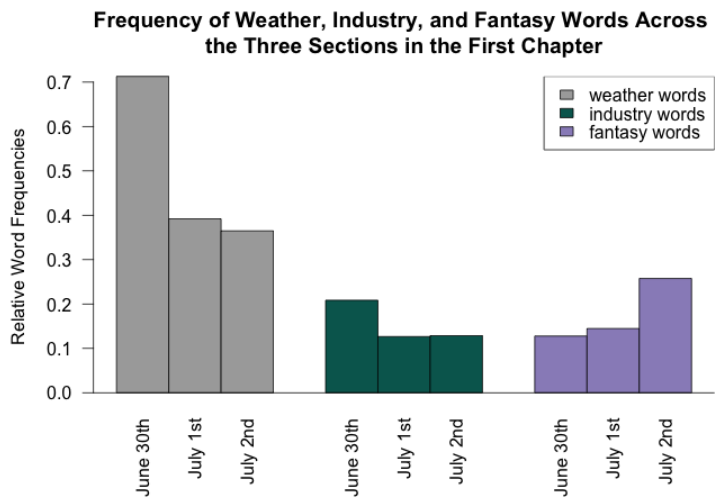
Figure 1. The presence of weather words, industry words, and fantasy words across the three sections of the first chapter (June 30th, July 1st, and July 2nd). The structure of the entire chapter mirrors the structure of the excerpts I have looked at in detail. Weather and industry words occur more frequently in the first section of the chapter than in later sections, while fantasy words figure more and more prominently as weather and industry word frequencies taper off. Climate and its causes are initially made present only to be superseded by a fantasy plot. For the words counted in each figure, see Appendix